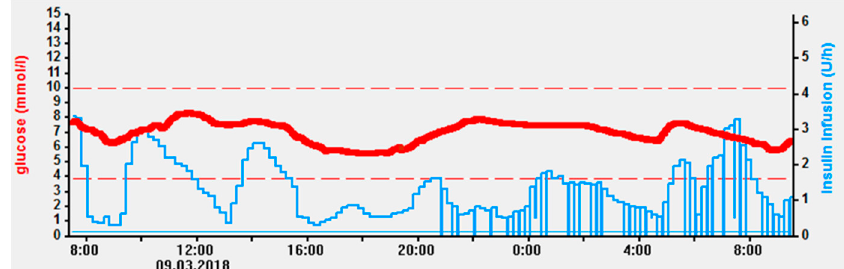
Figure 3. Profile of fully automated subcutaneous closed-loop insulin delivery over 24 h in a noncritical care patient [31]. A control algorithm modulates subcutaneous insulin delivery via an insulin pump (denoted in blue) according to interstitial sensor glucose values (denoted in red). (Kindly provided